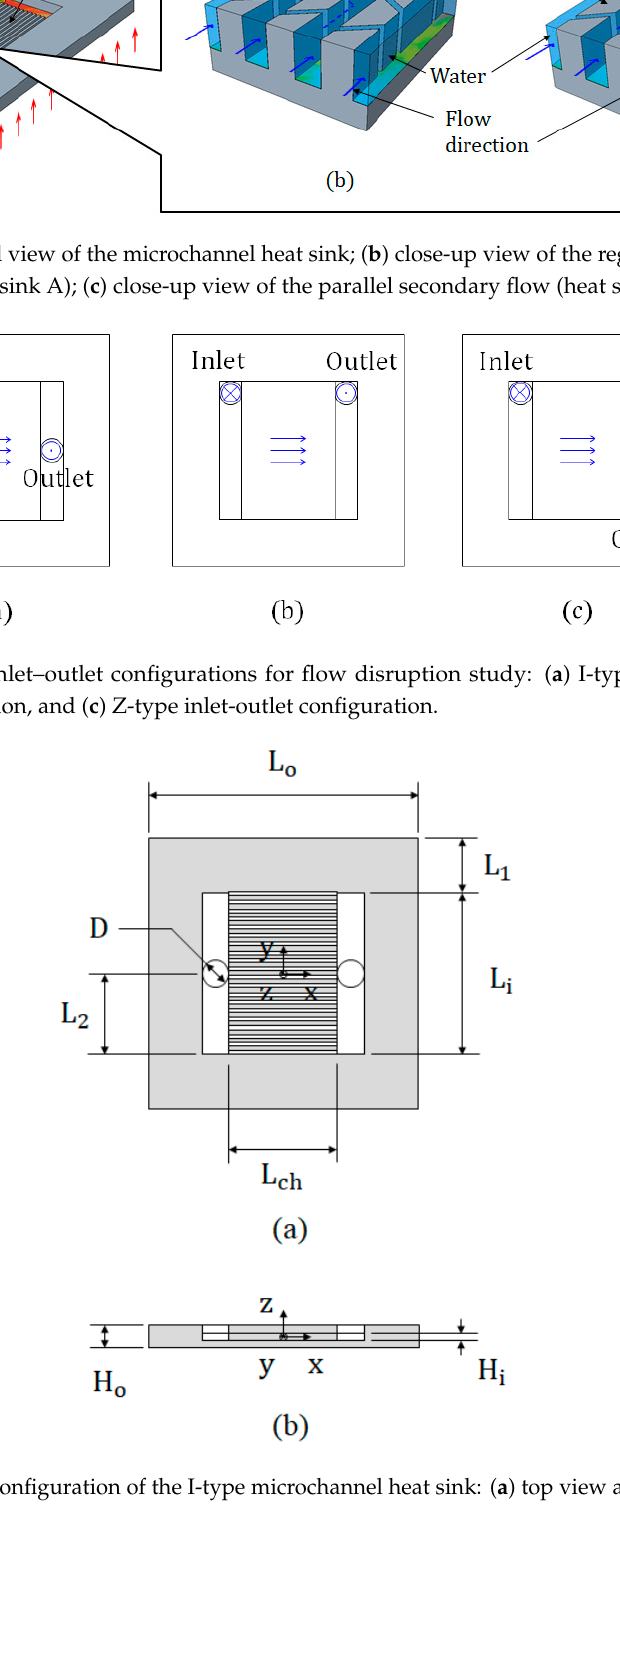
Figure 1. ( a ) Sectional view of the microchannel heat sink; ( b ) close-up view of the regular trapezoidal